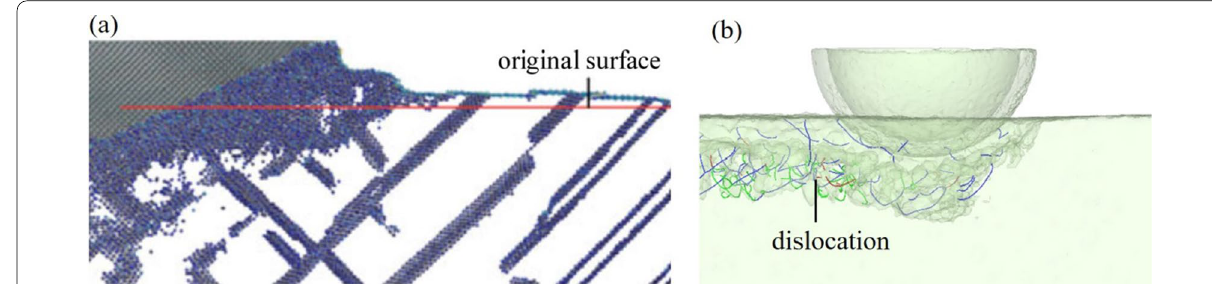
Fig. 7 Dislocation in nano-cutting of different single-crystal materials: a copper [21] and b gallium arsenide